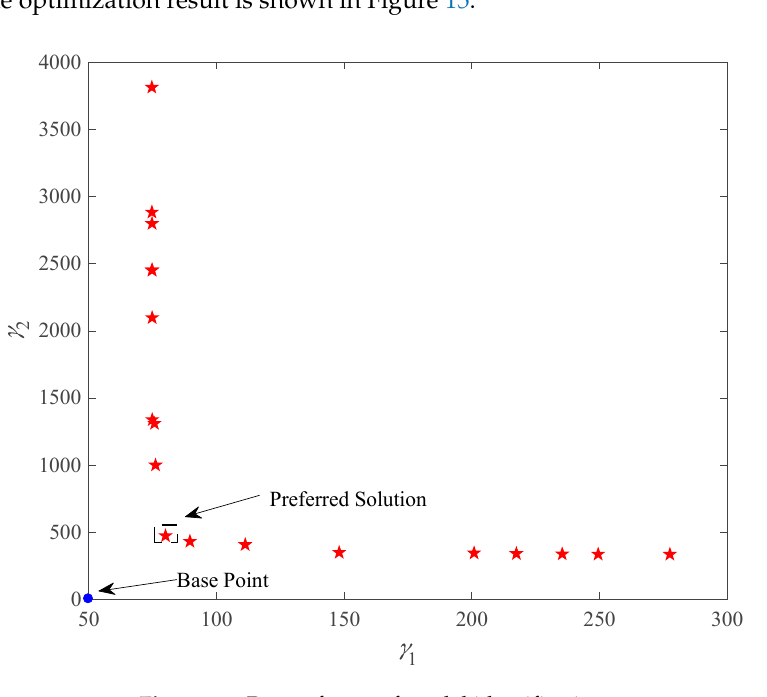
Figure 15. Pareto fronts of model identification.